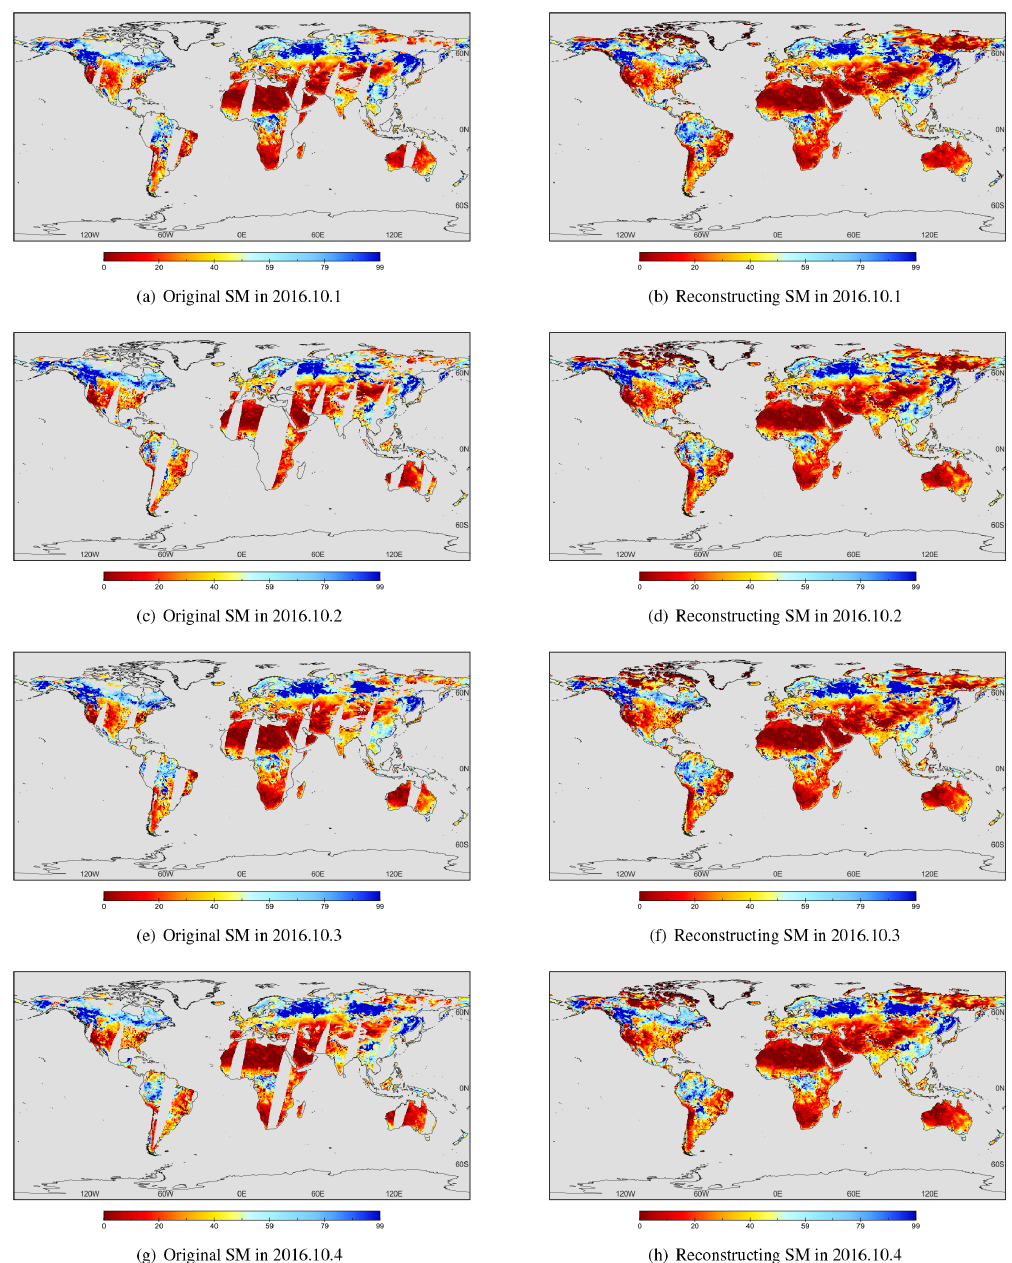
Figure 6. Original and reconstructed global daily SM results between 1 and 4 October